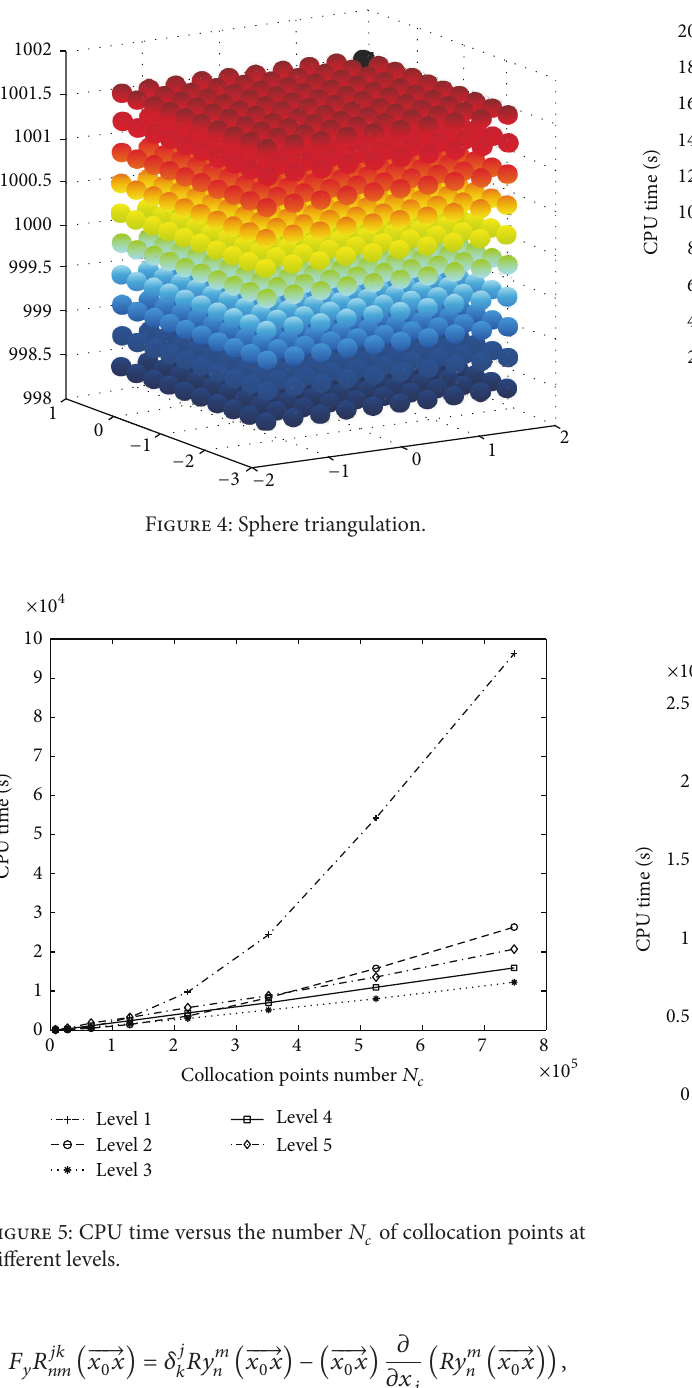
Figure 7: Zoom 2 of Figure